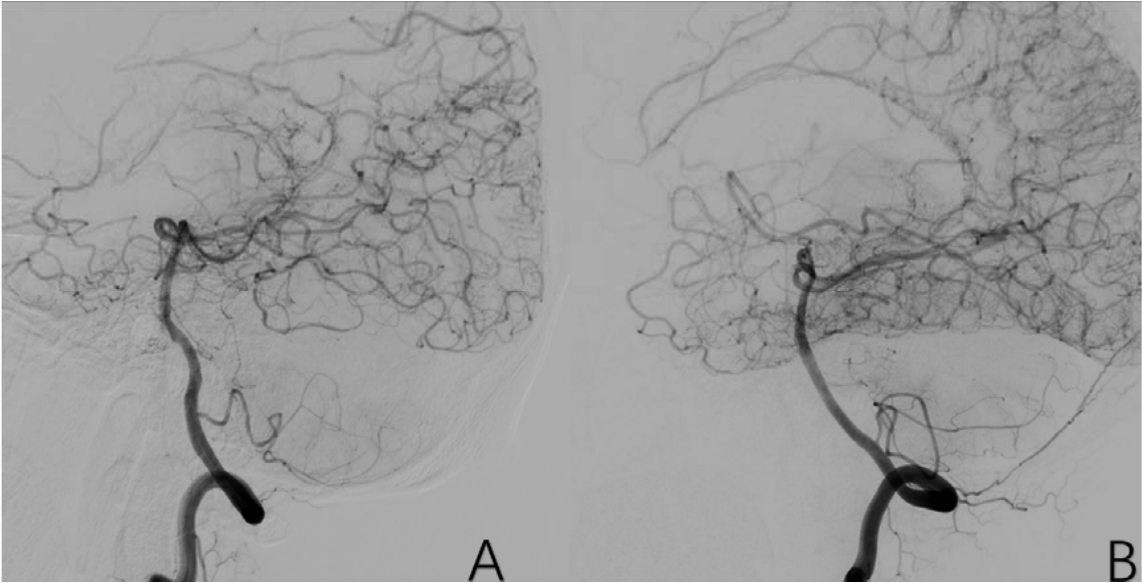
Figure 8. ( A ) is a 43-year-old male. ( B ) is a 32-year-old female. Both of them have typical posterior circulation compensatory imaging manifestations.